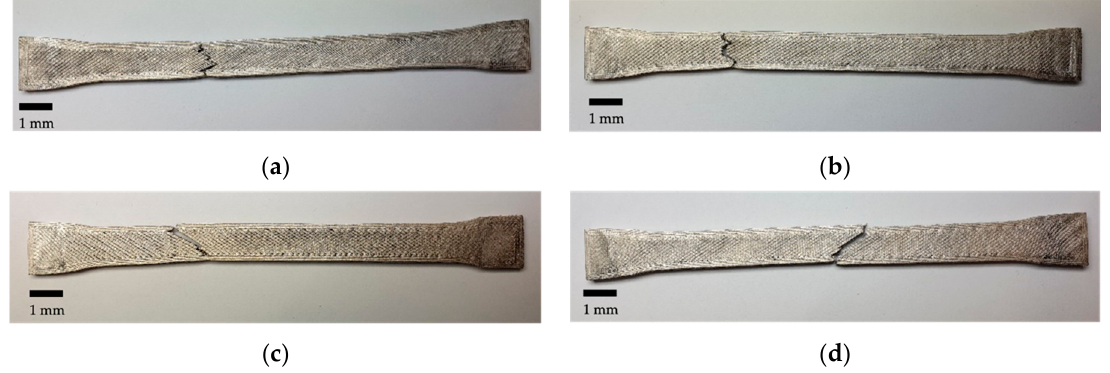
Figure 12. Fracture surfaces of the tensile specimens: ( a ) ID 25; ( b ) ID 50; ( c ) ID 75; ( d ) ID 100.